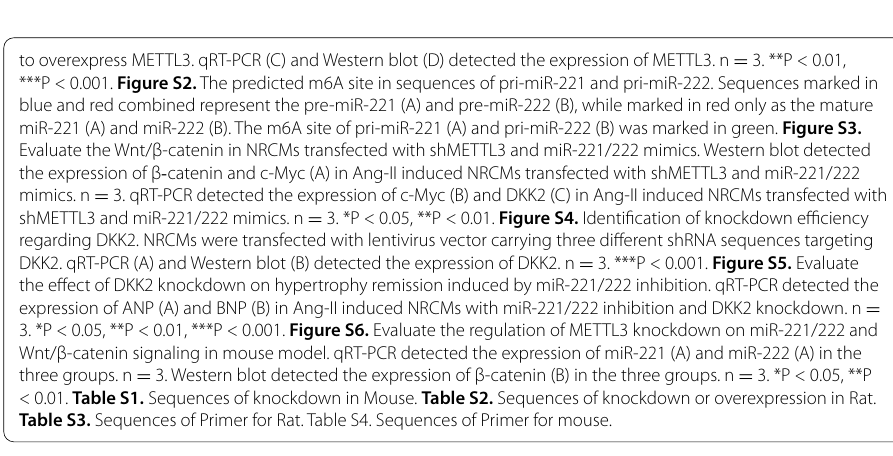
Table S3. Sequences of Primer for Rat. Table S4. Sequences of Primer for